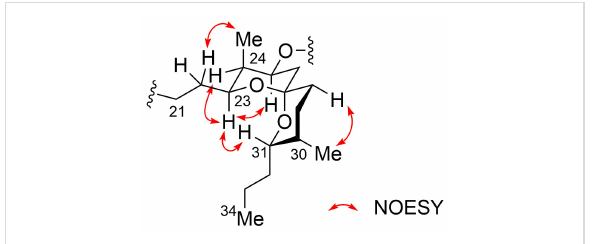
Figure 7: NOESY correlations for the spiroacetal moiety of compound 2 .